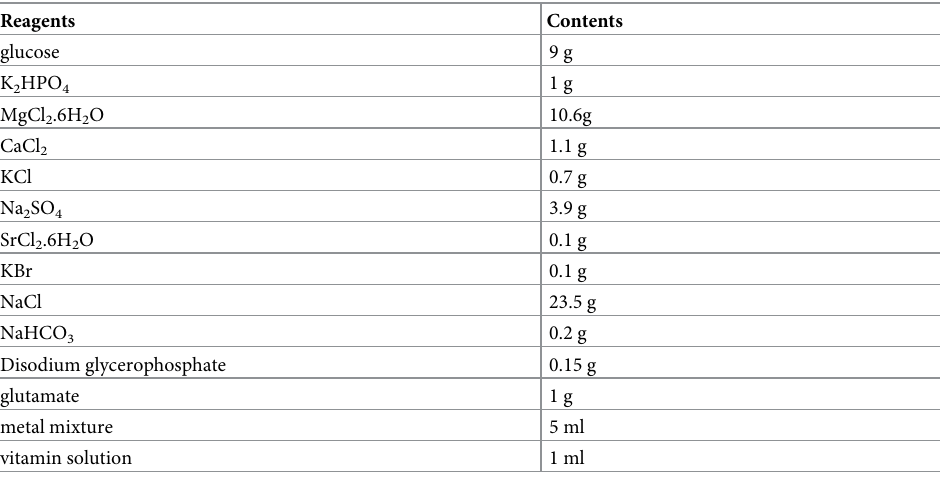
Table 1. The defined medium compositions per liter.